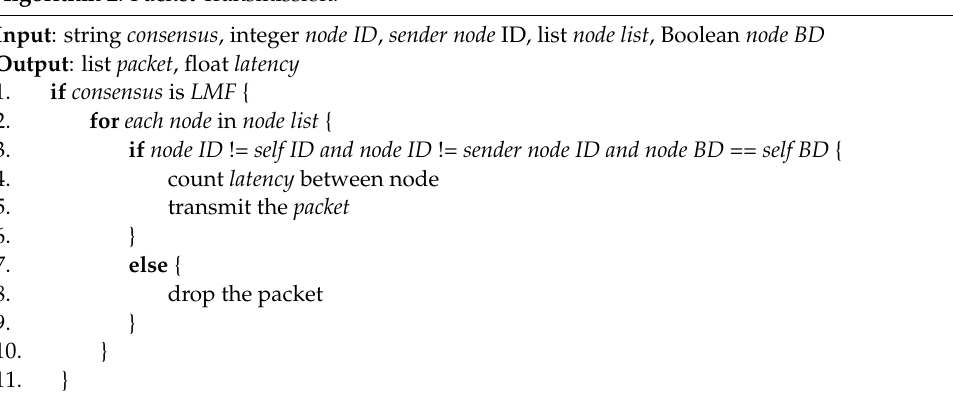
Algorithm 2 . Packet